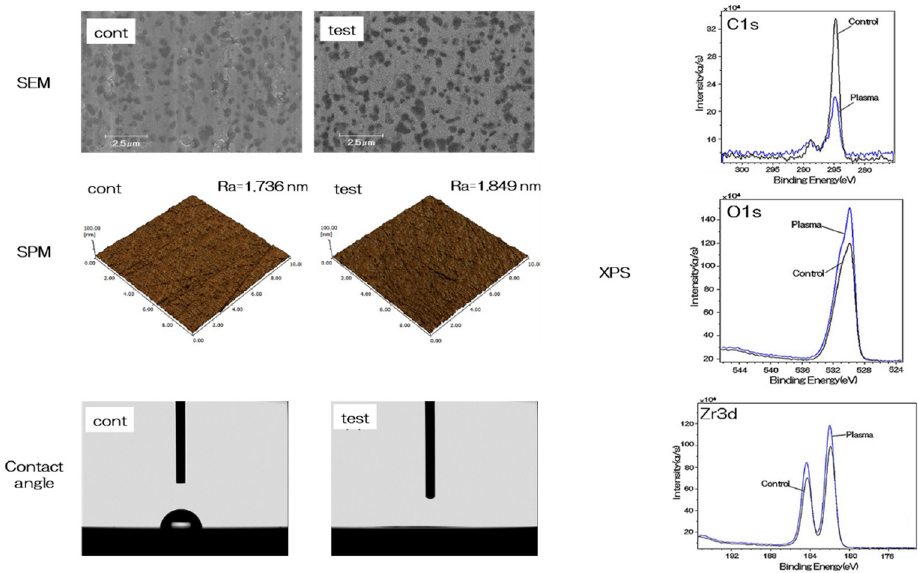
Figure 1. The surface analysis of the test and control NANOZR samples were showed. SEM analysis showed images specific to NANOZR in both the test group and the control group, and no change due to plasma treatment was observed. In addition, the SPM analysis showed Ra of 1.736 nm in the control group and 1.840 nm in the experimental group, showing no di ff erence in surface roughness. In XPS analysis (C1s, O1s and Zr3d), decrease of C1s peaks and increase of O1s and Zr3d peaks were observed on the material surface of the test group by alkali and plasma treatment to NANOZR surface. The contact angle analysis showed 63 ◦ on the material surface of the control group, while showing superhydrophilic on the material surface of the test group.